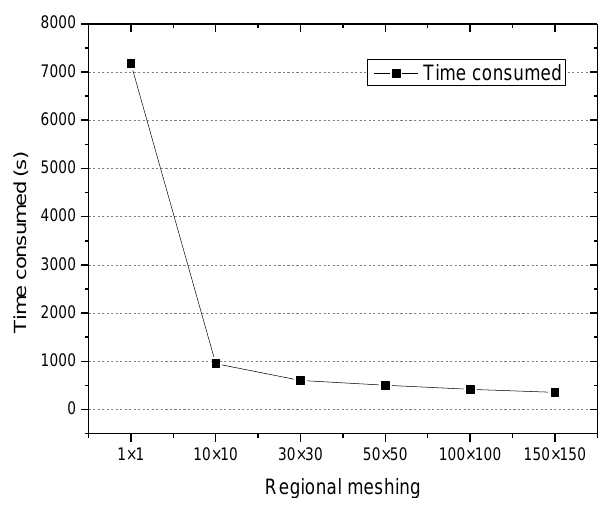
Figure 4. Time consumed.